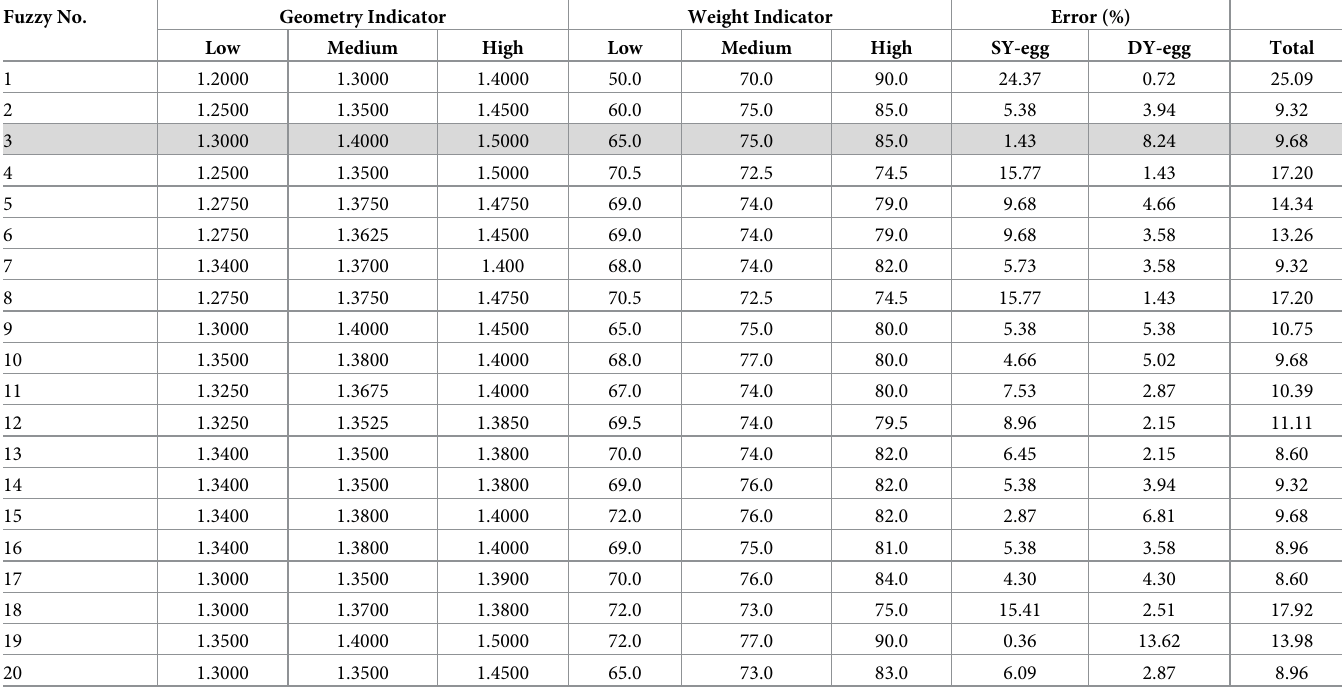
Table 3. Shape of the input membership function and results. Fuzzy